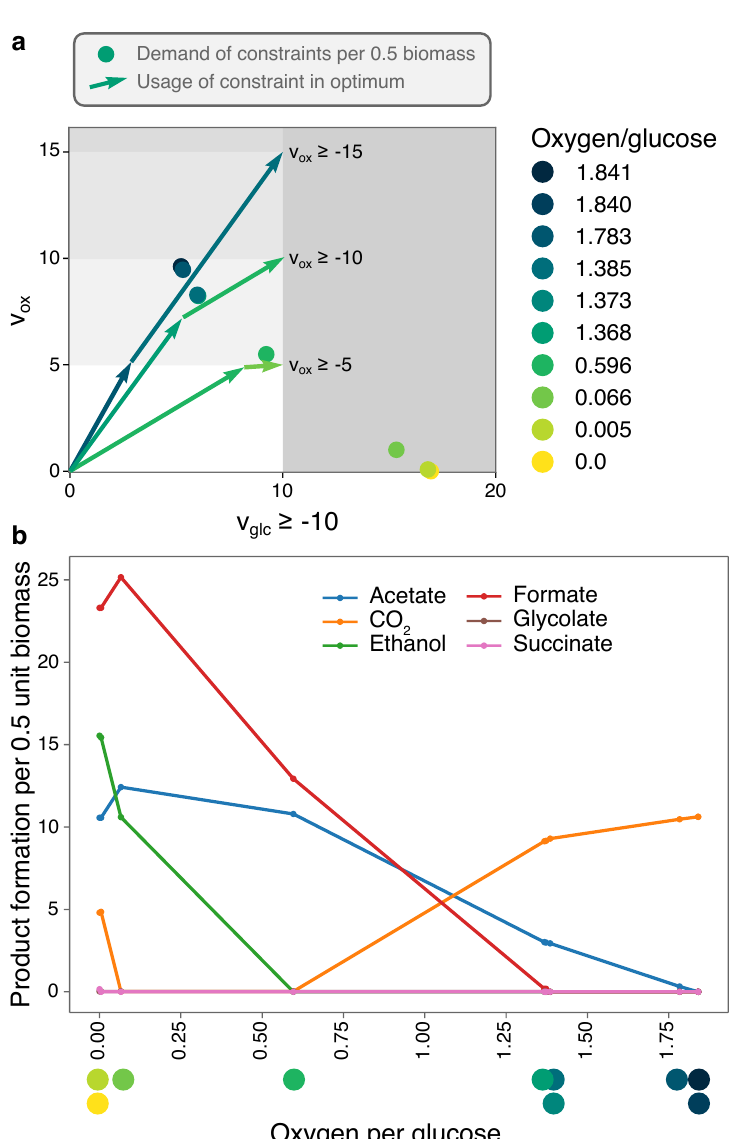
Figure 3. The full flexibility of E. coli under glucose- and oxygen-limitation can be visualized with 10 EMs. We used the set of elementary conversions between glucose, oxygen, and biomass production that are possible in a genome-scale model of E. coli reported in [22]. For each ECM the demand of the constraints per 0.5 unit biomass is plotted in ( a ) and characterized with its oxygen per glucose requirement. ( b ) By reconstructing for each ECM a corresponding EFM (see Methods), we could reconstruct which products are secreted by each ECM. This information is given for all shown ECMs as a function of the oxygen/glucose requirement. The three different oxygen-bounds show that under increasing oxygen-limitation, the number of different fermentation products increases. When two neighboring dots are far from each other ( a ), there is a large regime of oxygen-limitation in which the corresponding EMs are used together. Some dots are so close together that the co-utilization of the EMs is highly